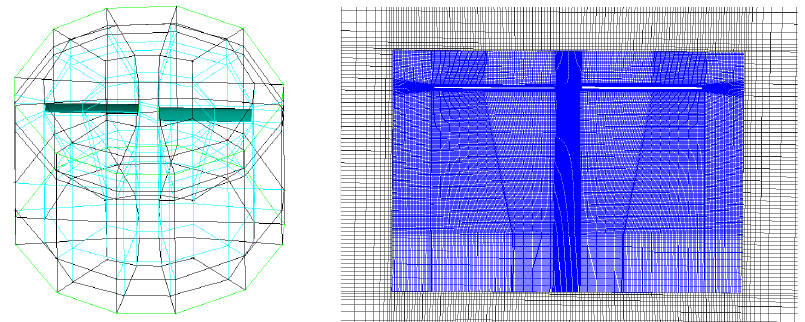
Figure 4. Improved Caradonna–Tung grid topology and spatial sectional grid.